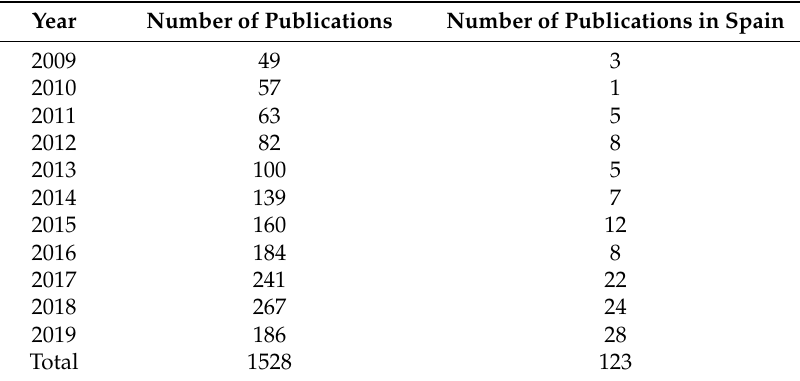
Table 1. Number of publications per year.